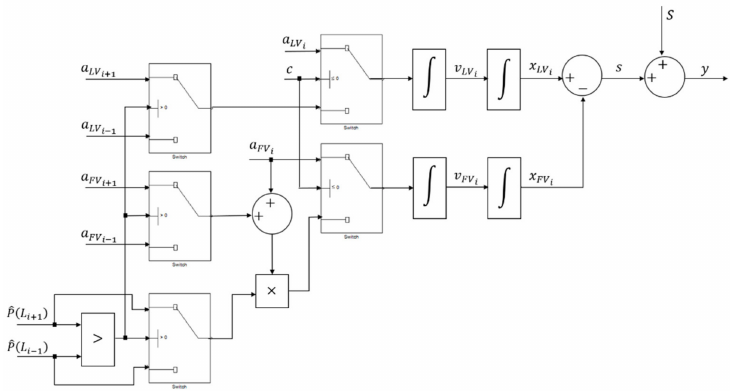
Figure 4. Proposed modified car-following